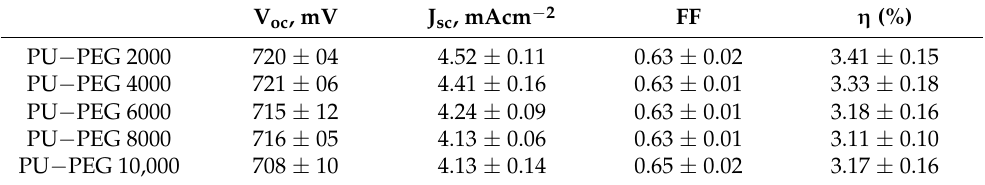
Table 2. Photovoltaic performance of DSSCs based on PU matrices with different PEG molecu- lar